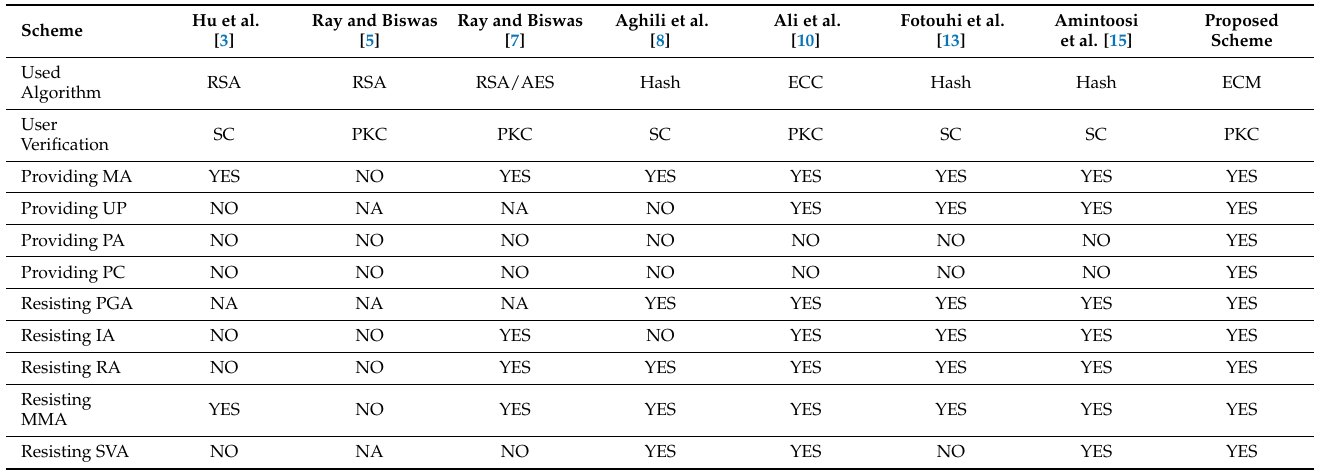
Table 6. Functionality